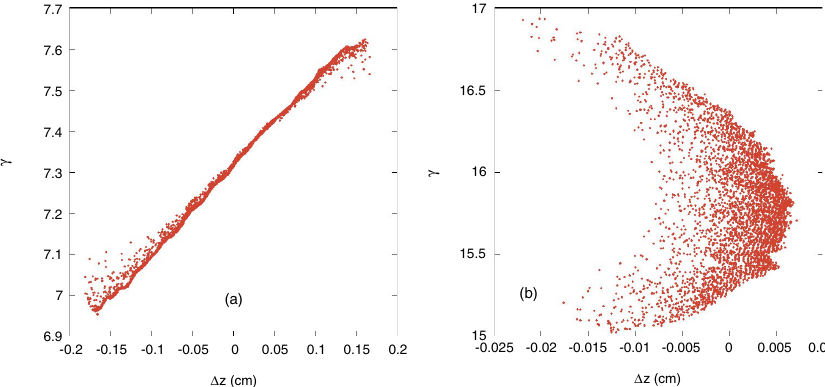
FIG. 21. (Color) PARMELA simulation of the longitudinal phase space (a) before the compressing rf section and (b) after the section. A clear debunching correlation is present and must be removed at the beginning of the bunching